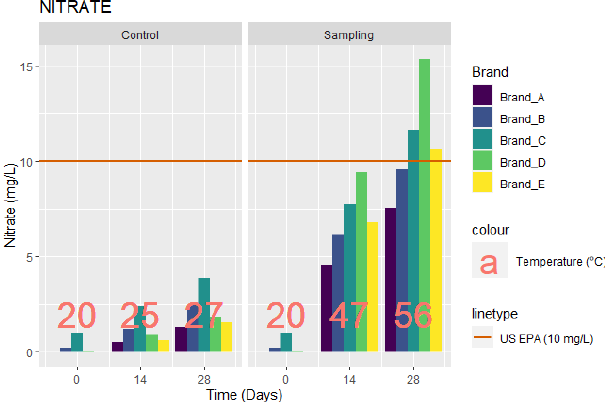
Figure 4. Nitrate values for the control group and sunlight exposure